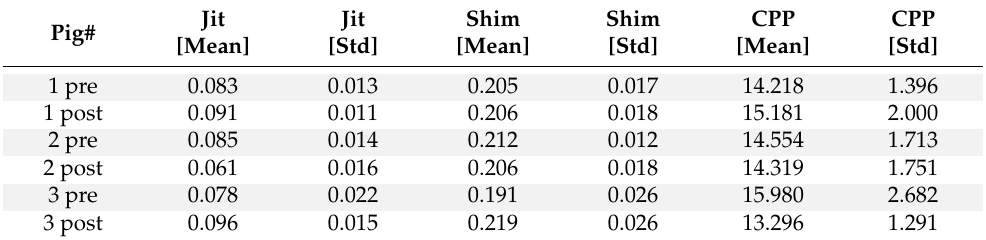
Table 4. Mean and standard deviation (std) of F0-based parameters for all pigs pre- and post-surgery. Jit Jit Shim Shim Pig# [Mean] [Std] [Mean]